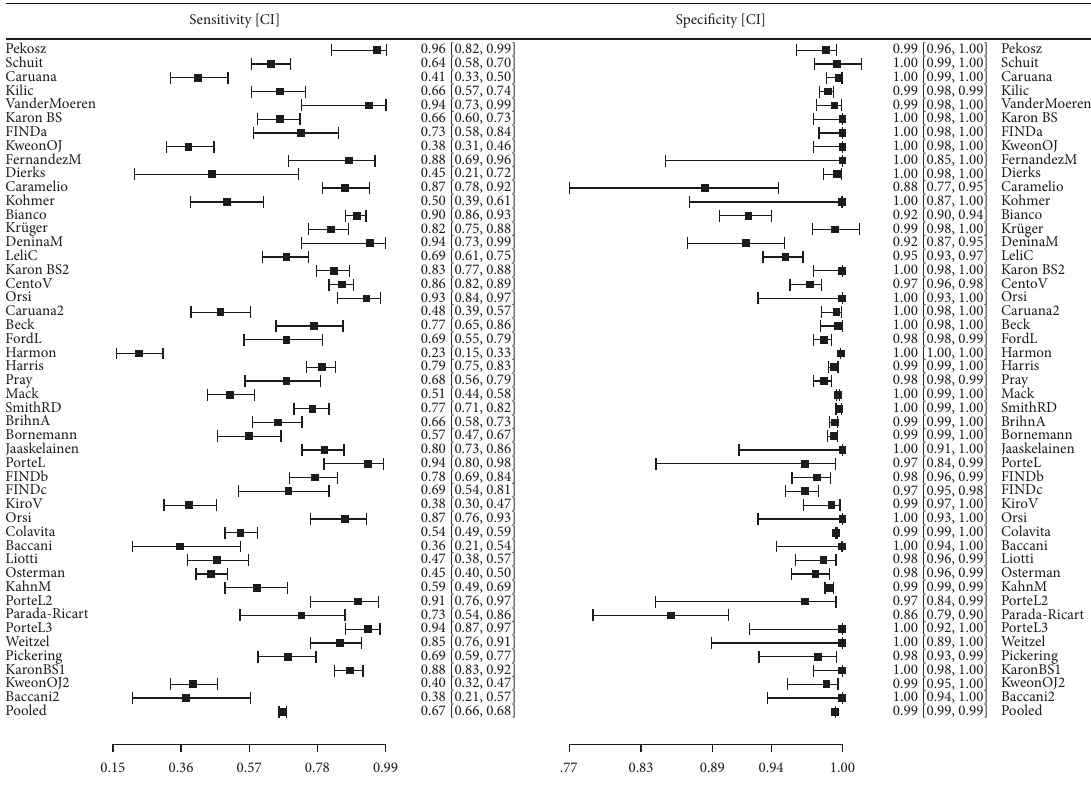
Figure 2: Forest Plots for all studies.Test for equality of sensitivities: χ 2 1776.08, df 47, p 0 . 01. The list of studies shown here has the same order as in Table 1. χ 2 (cid:31) (cid:31) <